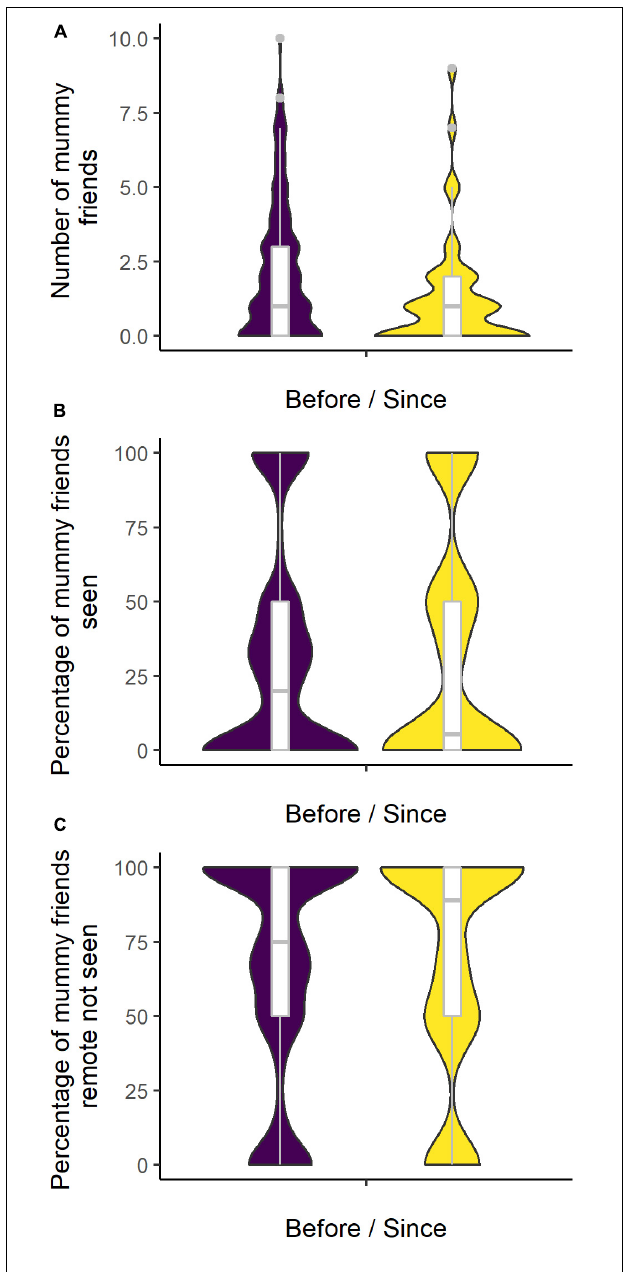
FIGURE 2 | (A–C) Violin plots show the density distribution of network characteristics in relation to mummy friends by timing of birth, with in-set box plots showing the median and interquartile range [ (A) N = 162; (B,C) n = 107].